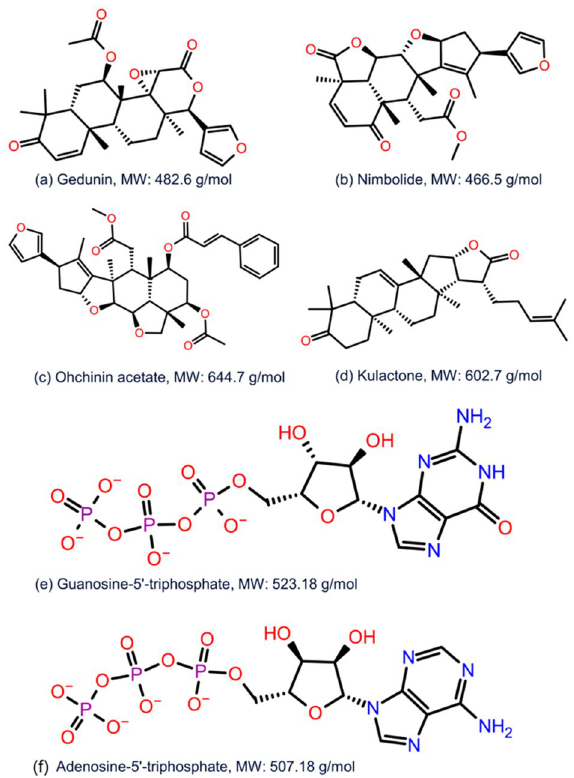
Figure 1. 2D structural formula and molecular weight for the selected bioflavonoids, i.e., ( a ) Gedunin, ( b ) Nimbolide, ( c ) Ohchinin acetate, and ( d ) Kulactone and reference ligand, viz. ( e ) Guanosine-5 ′ -triphosphate ( f ) Adenosine-5 ′